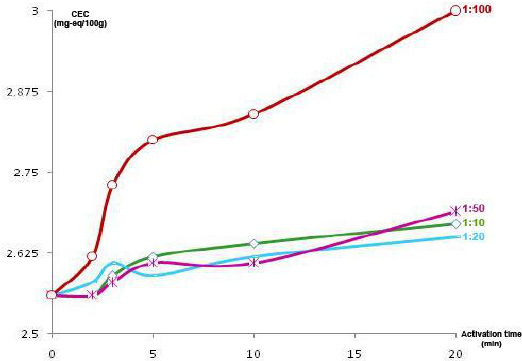
Fig.4. Cation exchange capacity of the raw and milled